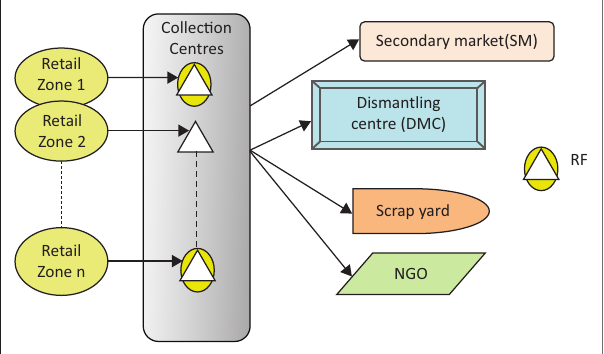
FIGURE 1: Reverse logistics network